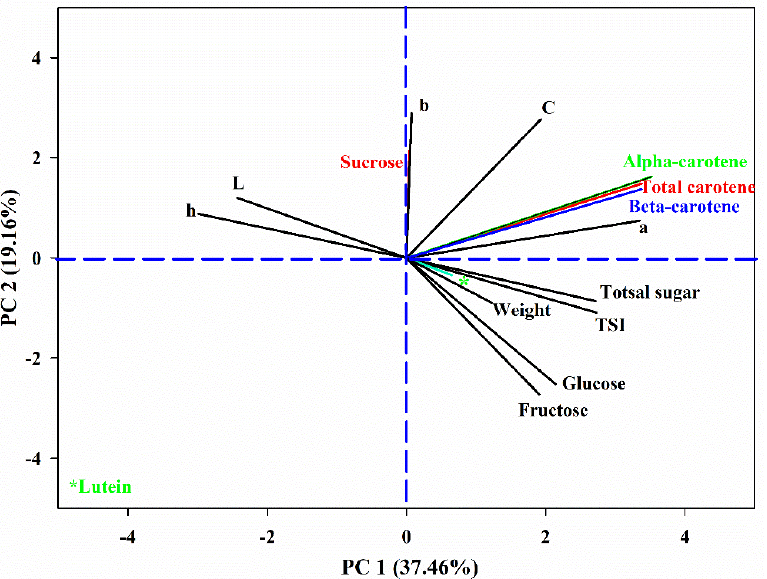
Figure 4. Principal component analysis (PCA) of color attributes, root weight, carotenoids (lutein, α -carotene, and β-carotene), free sugars (glucose, fructose, and sucrose), and total sweetness index (TSI) in carrot root ( n = 180). The lines starting from the center point of the bi-plot show the positive or negative associations of the parameters.